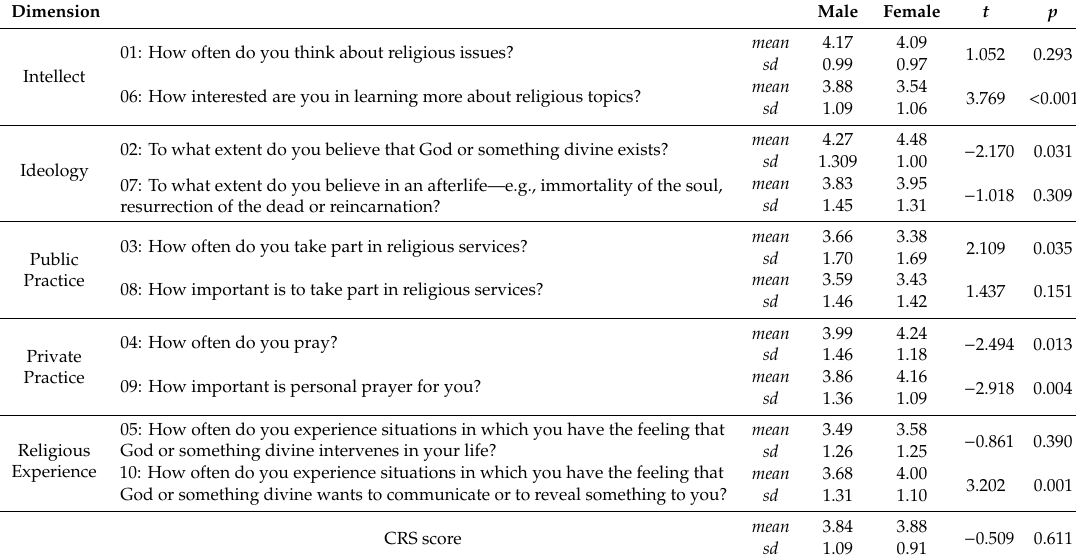
Table 4. CRS items T-tests: Di ff erences between men and women. Dimension Male Female t